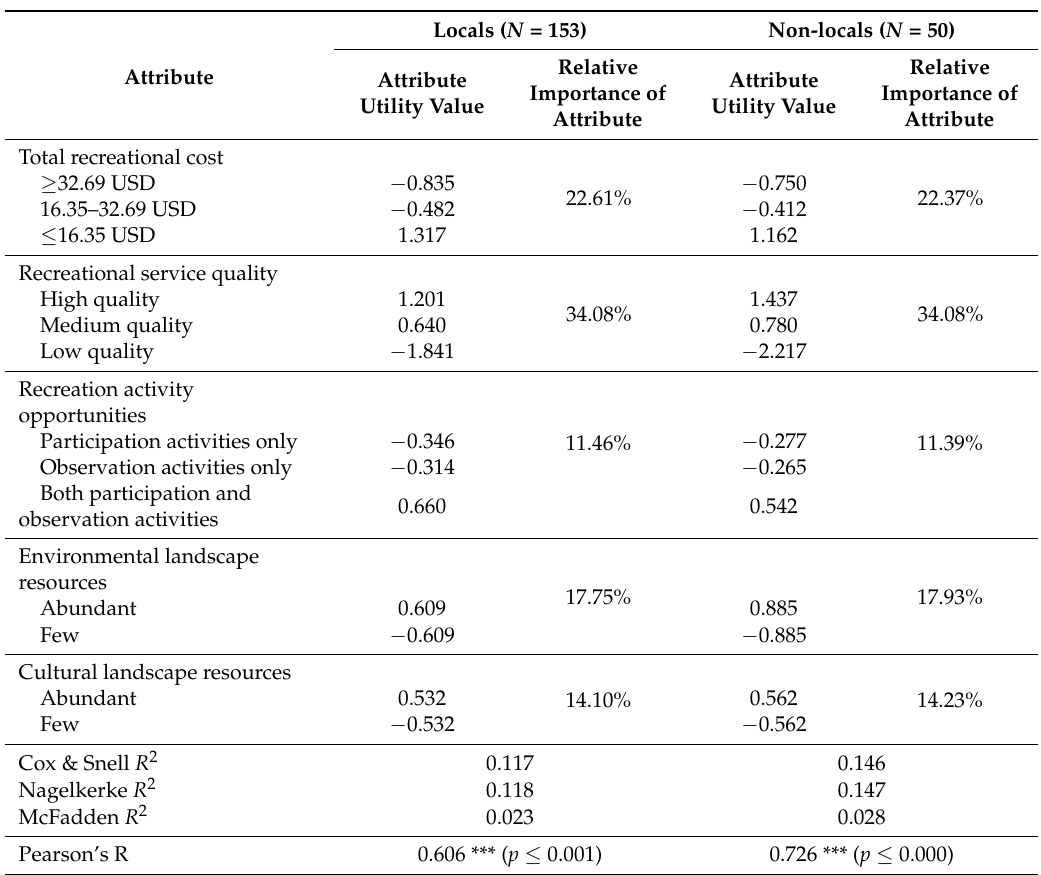
Table 8. Comparison of the results for the preferences of local and non-local visitors to the Calligraphy